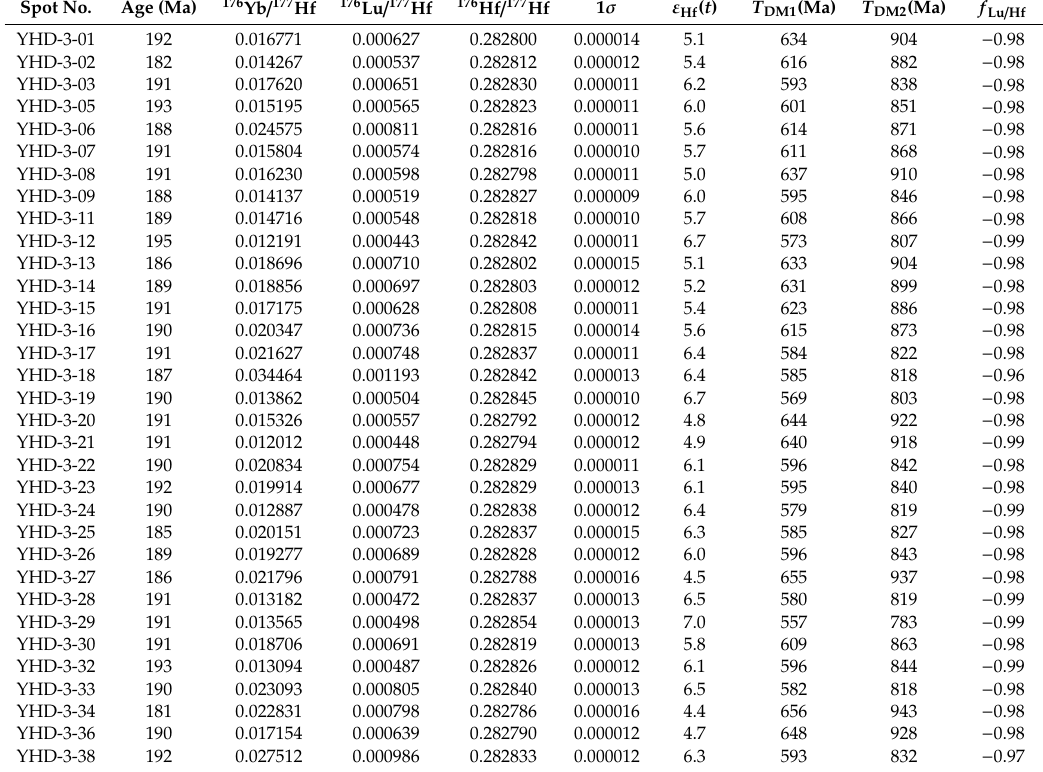
Table 3. The results of the Hf isoptope analysis for the single-grain zircon in the ore-bearing porphyry of the Yanghuidongzi